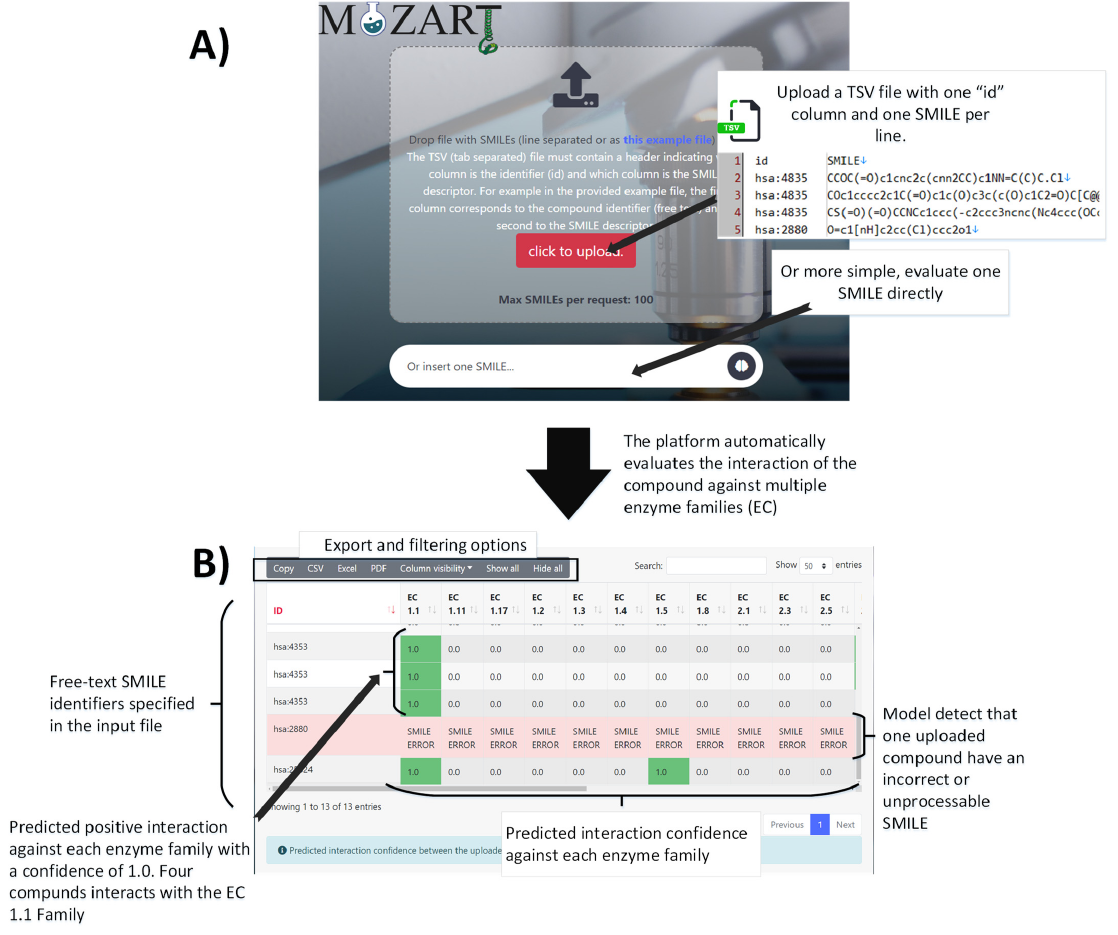
Figure 2. Workflow illustration of the MOZART platform execution. Panel ( A ) depicts the input platform panel, where the user could upload a TSV file or write SMILES in the input box to evaluate their interaction. Panel ( B ) presents the result platform table with the predicted interaction confidence of each SMILES compound against each enzyme family (EC). The background red row depicts an unprocessable SMILES, whereas the green background column depicts each positive predicted interaction against each EC.